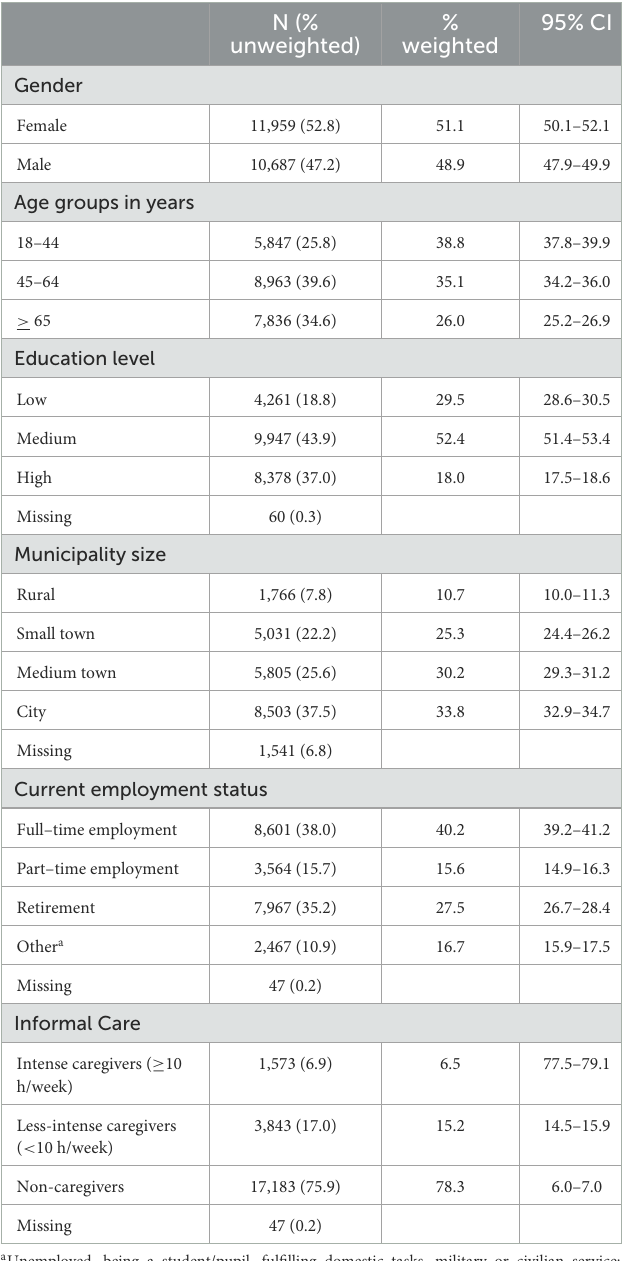
TABLE 1 Sample characteristics (total sample: n = 22,646).